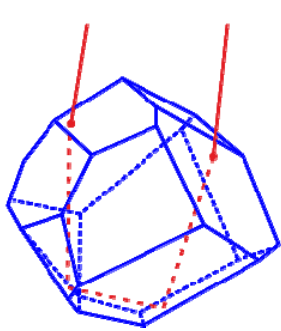
Figure 7. Visualization of non-specular trajectory presented in Fig.